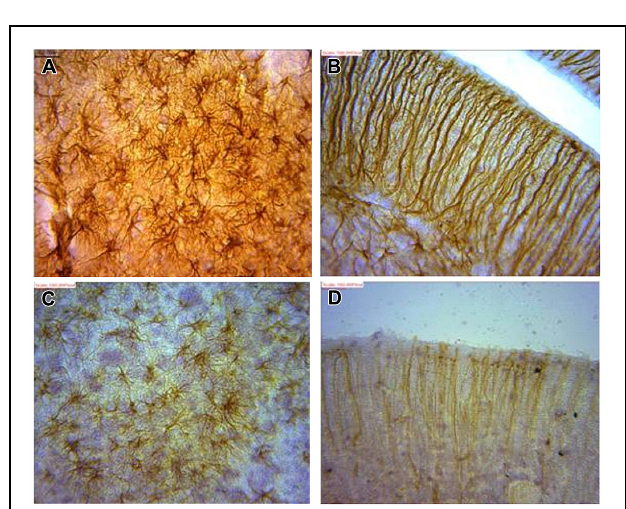
FIGURE 5 | Astrocytes in (A) dentate gyrus (DG) and (B) cerebellum of juvenile African giant rats (AGR) showing greater intensity of GFAP signaling as against corresponding areas of adults AGR